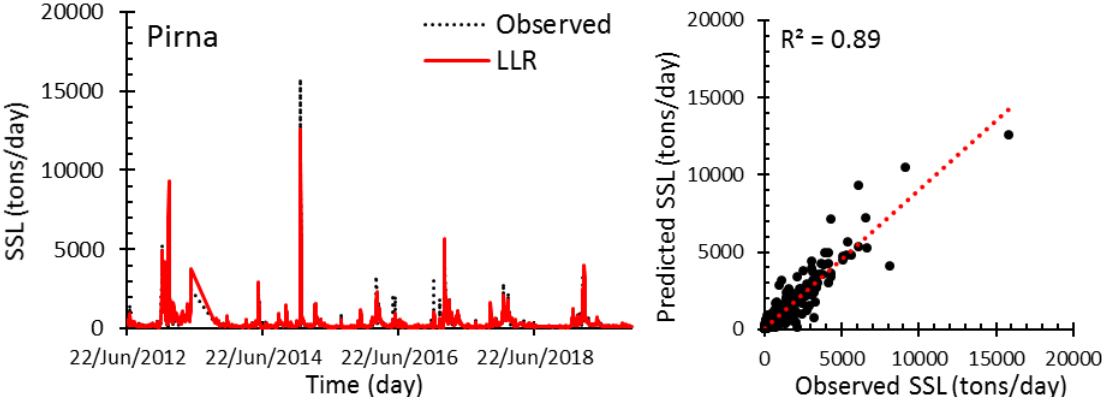
Figure 10. Observed and predicted SSL of the best LLR model for the Pirna station in a testing phase.